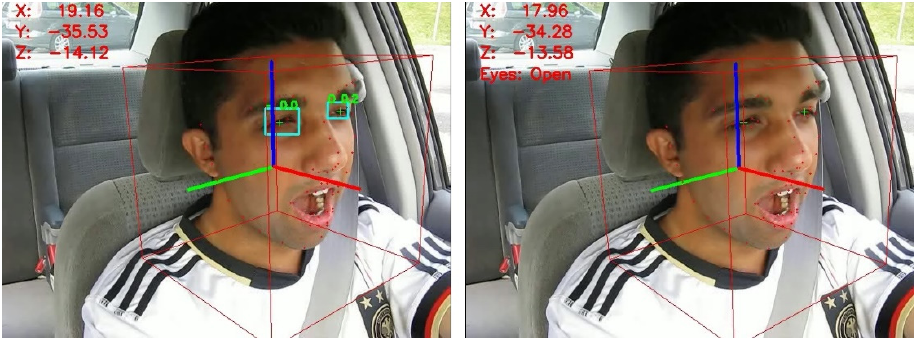
Figure 5. Detection of eye opening and closing using a CNN ( left ) and the EAR metric ( right ). The images also indicated the orientation of the face in the detection of head posture.